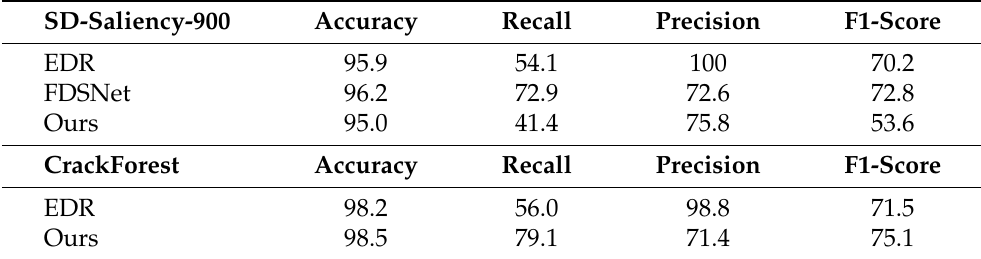
Table 2. Quantitative pixel-level defect detection results among different